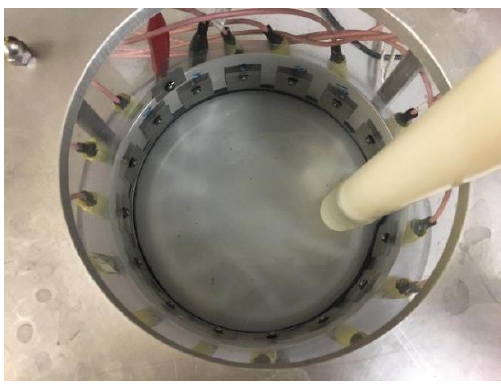
Figure 5. The experimental set up with the 2D ERT tank unit with tap water as a background.